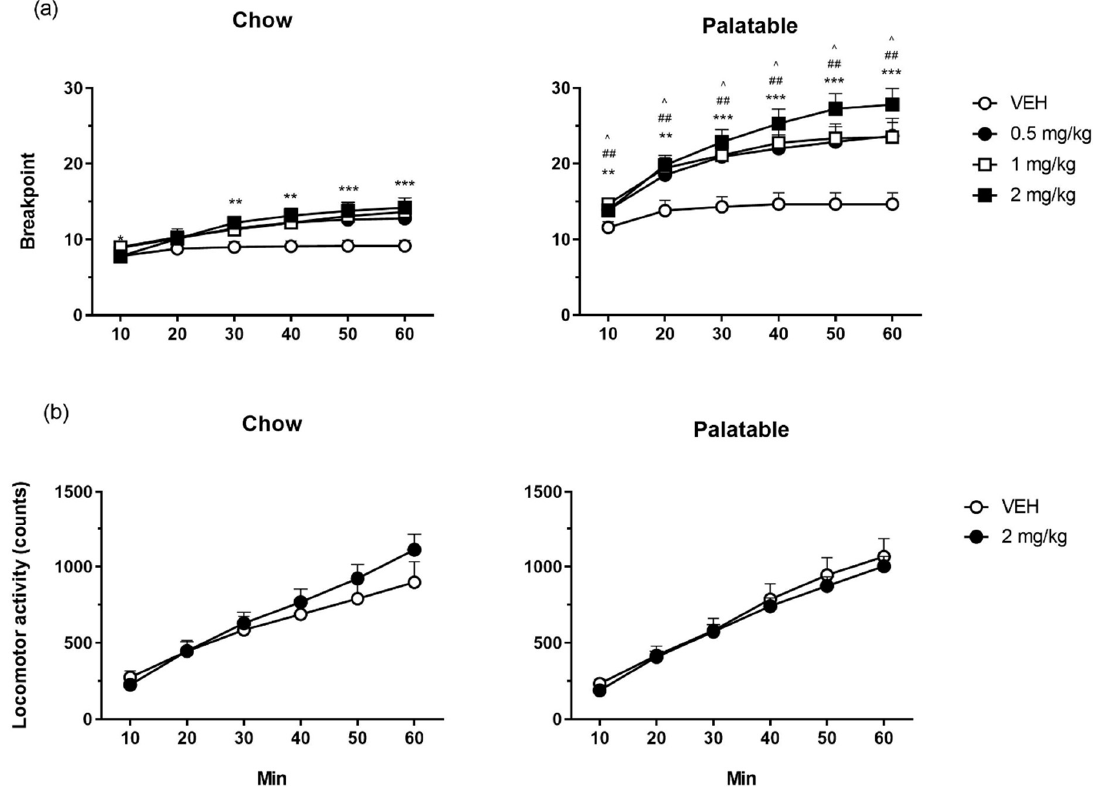
Figure 2. The effects of prazosin on breakpoint time course in a progressive ratio schedule of reinforcement task ( a ) and on counts’ time course in a locomotor activity test ( b ), in Chow and Palatable rats. Prazosin dose-dependently increased PR breakpoint, more potently and more efficaciously in Palatable rats than Chow rats, without significantly altering locomotor activity levels. The data are presented as mean + SEM. Symbols indicate a significant difference from vehicle (VEH) within each group; 0.5 mg/kg: ^ p < 0.05; 1 mg/kg: ## p ≤ 0.01; 2 mg/kg: ** p < 0.01, *** p < 0.001.